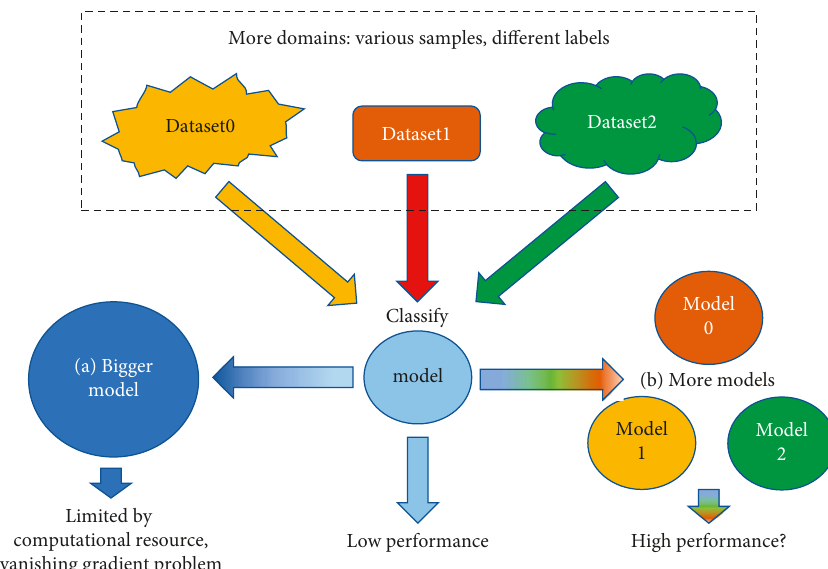
Figure 1: The solutions to classify the samples of multiple domains. (a) Bigger model. (b) More